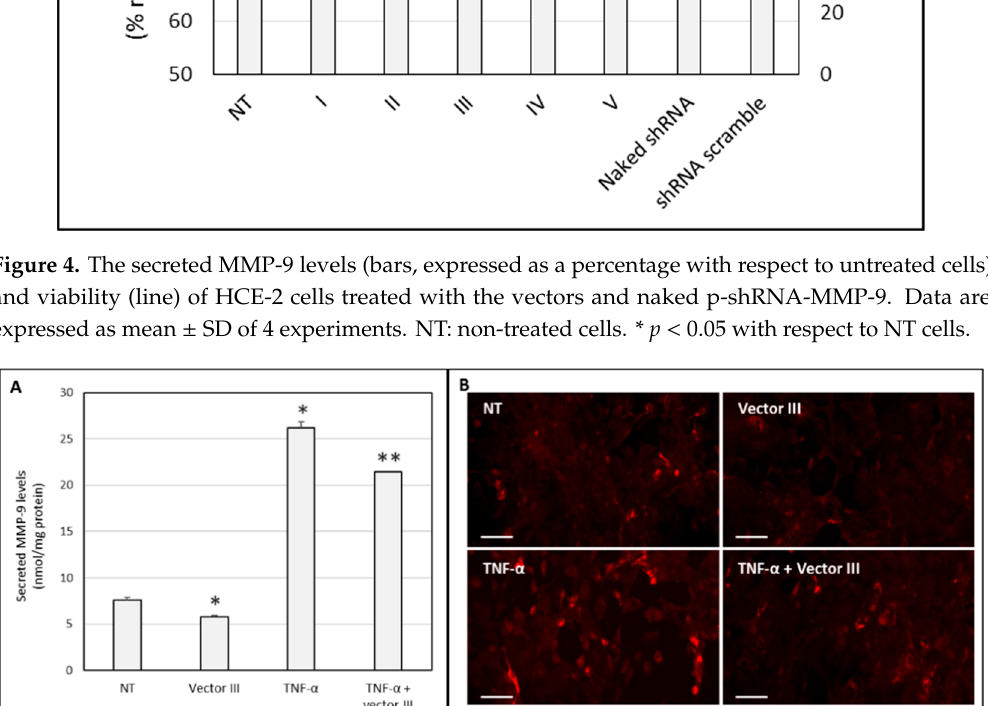
Figure 4. The secreted MMP-9 levels (bars, expressed as a percentage with respect to untreated cells) and viability (line) of HCE-2 cells treated with the vectors and naked p-shRNA-MMP-9. Data are expressed as mean ± SD of 4 experiments. NT: non-treated cells. * p < 0.05 with respect to NT